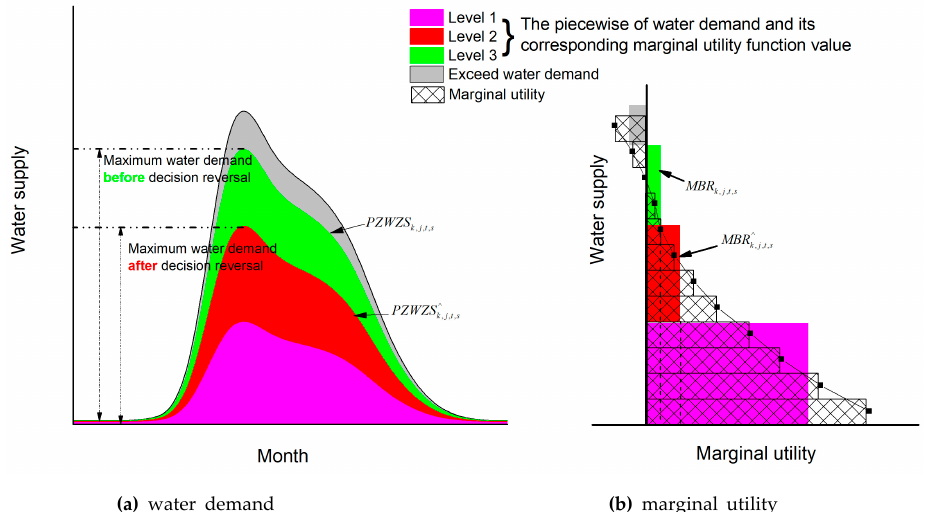
Figure 2. The comparison of water demand before and after decision reversal as well as marginal utility. ( a ) water demand; ( b ) marginal